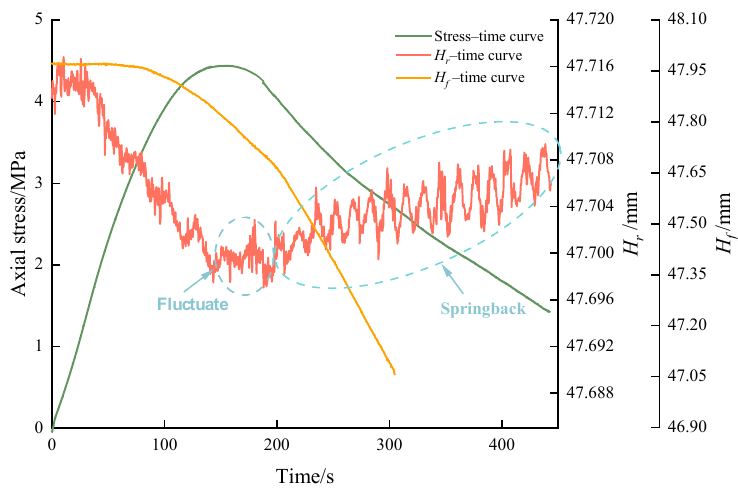
Figure 17. Axial stress, H r , and H f curves of sandstone–CGFB composite samples versus time.